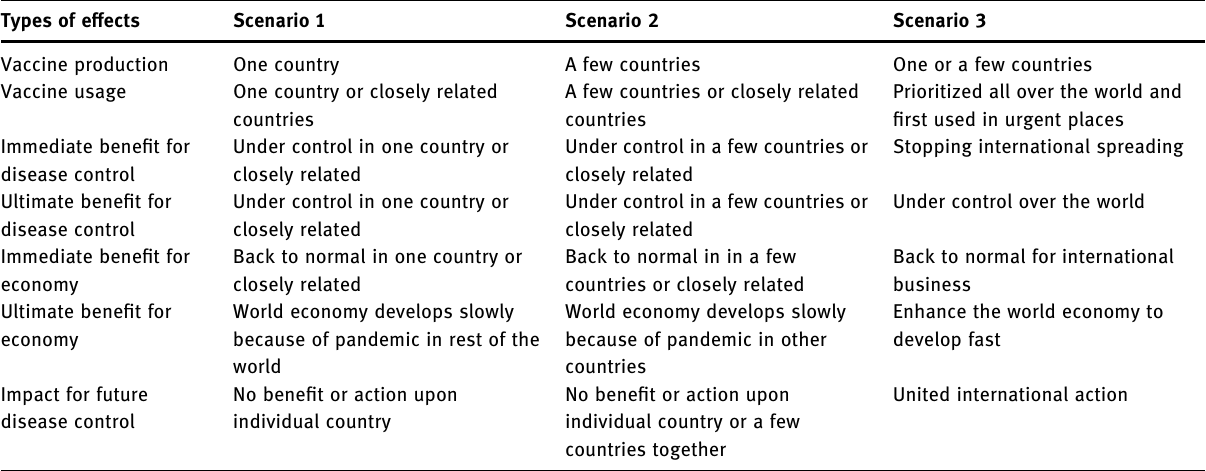
Table 1: Impact of di ff erent usages of vaccine Types of e ff